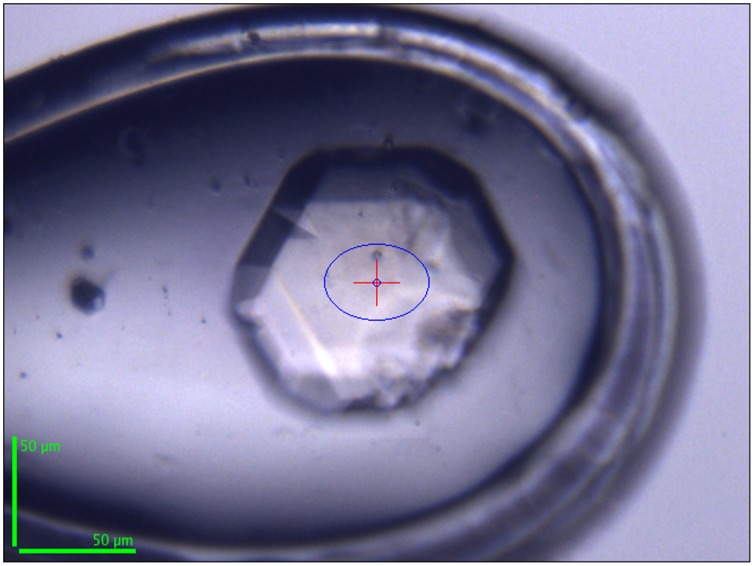
PaoD crystal (0.1×0.08×0.08 mm3) obtained with condition 2 (P3121).The protein was thawed in presence of 0.4 M of [C2OHmim]PF6. The crystallization condition was 12% PEG 4 K, 0.1 M Tris-HCl pH 8.5 and 10 mM cysteine. The same crystal morphology was obtained for the P6122 crystals grown from ammonium sulphate. The image was captured on the synchrotron beamline ID23-1 (ESRF, France).